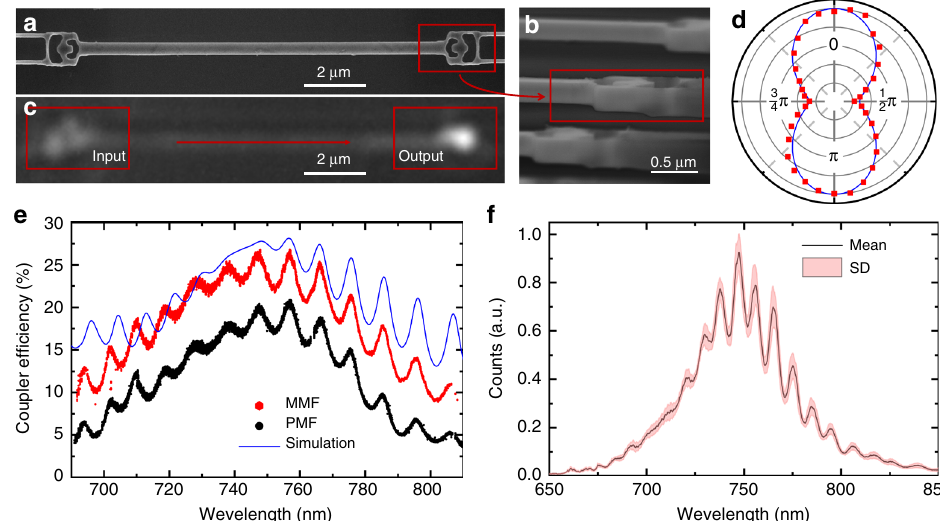
Fig. 2 Inverse-designed vertical couplers. a Scanning electron micrograph of two vertical couplers connected by a waveguide. This device is used to characterize the ef fi ciency of the vertical couplers. b Sideview of the vertical coupler, showing the undercut of the structure at an 85° angle. c Optical microscope image when focusing a Gaussian beam on the coupler on the left (input) and detecting the transmitted light from the coupler on the right (output). d Polarization scan shows that the vertical couplers preferentially couple to a Gaussian beam with a polarization perpendicular to the nanobeam. Simulated polarization dependence, shown as a blue line, are in good agreement with the measured data (red squares). e Ef fi ciency of a single vertical coupler, peak ef fi ciencies are ≈ 21% for single-mode polarization-maintaining fi bers (PMF, black) and ≈ 26.5% for multimode fi bers (MMF, red). Numerical simulation results are shown as a blue line. f Transmission spectra of 15 different devices using a supercontinuum source. The solid black line corresponds to the mean value and the red shaded area corresponds to the standard